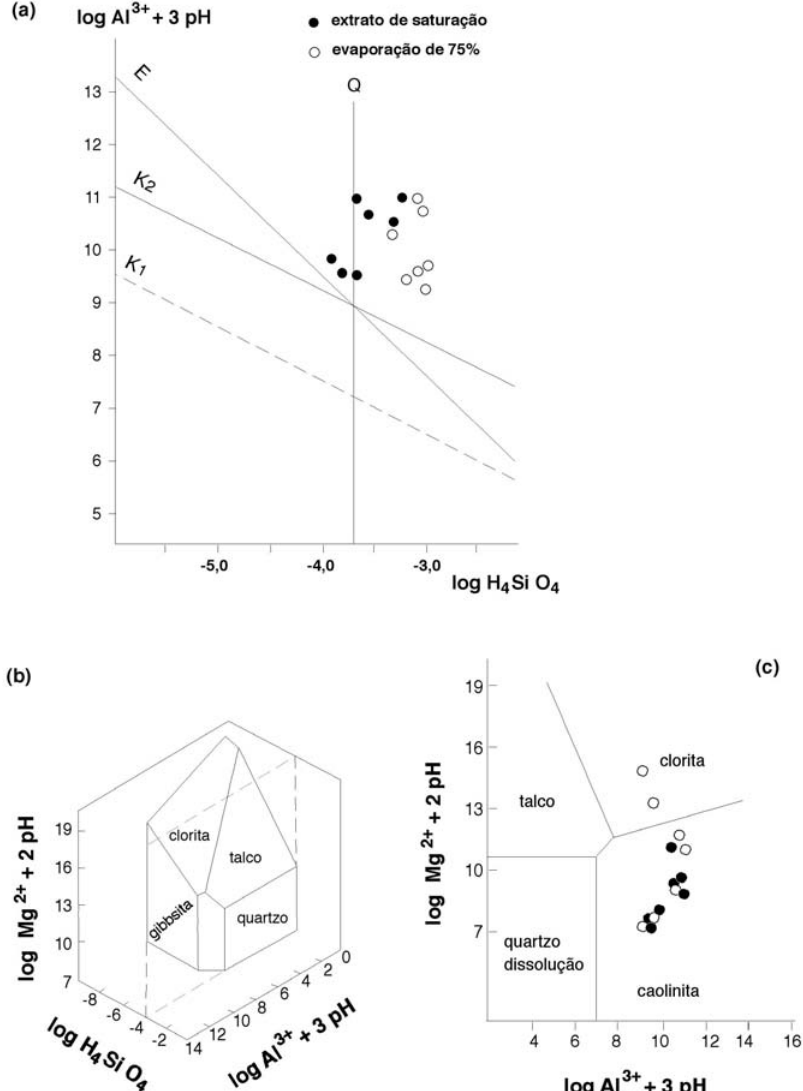
Figura 8. Avaliação da estabilidade dos minerais a partir dos extratos de saturação dos horizontes B e C dos solos derivados de serpentinitos em condições de equilíbrio e após um processo de evaporação de 75 % de umidade (simulação por computador). (a) Diagrama do sistema SiO 2- Al tantes termodinâmicas de duas caulinitas de diferentes graus de cristalinidade (caulinita k1: Sarazin, 1979; caulinita k2: Kittrick, 1966) e uma esmectita (E), considerando para esta última (Mg 2+ ) = 10–3,5pH e (Fe 2+ ) = 2,70–3pH. (b) Aplicação do diagrama de Bowers et al. (1984), para sistema SiO H O (Chesworth, 1997 - comunicação pessoal). (c) Seção do diagrama anterior correspondente a log 2 (H SiO ) = 4 4